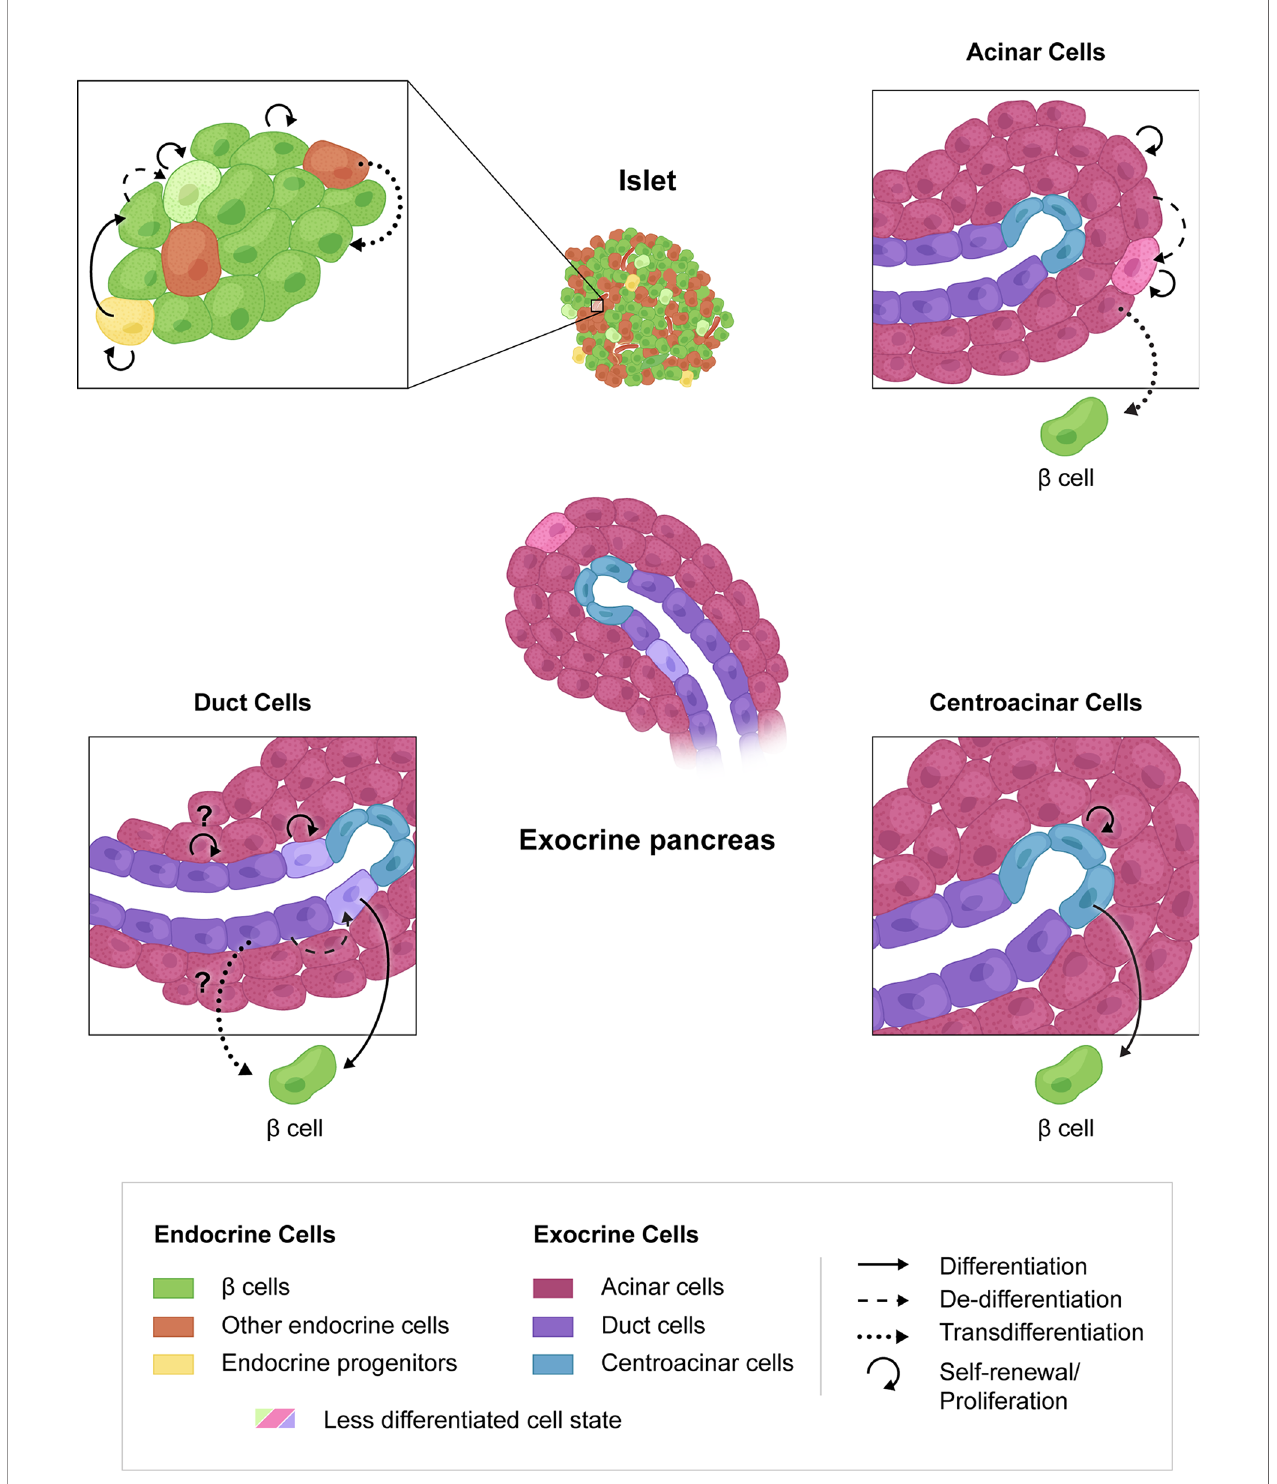
FIGURE 1 | Mechanisms of b cell regeneration through proliferation, progenitor differentiation or transdifferentiation. b cell proliferation is the most direct route to regeneration of b cell mass (upper left, circular arrow). The presence of endocrine progenitors in human islets is unknown but could lend to increased b cell mass. Transdifferentiation from other endocrine cells (upper left), acinar cells (upper right), duct cells (lower left) or centroacinar cells (lower right) may also be targeted for b cell regeneration. Possible cell interconversions that have not been shown experimentally are indicated by question marks.